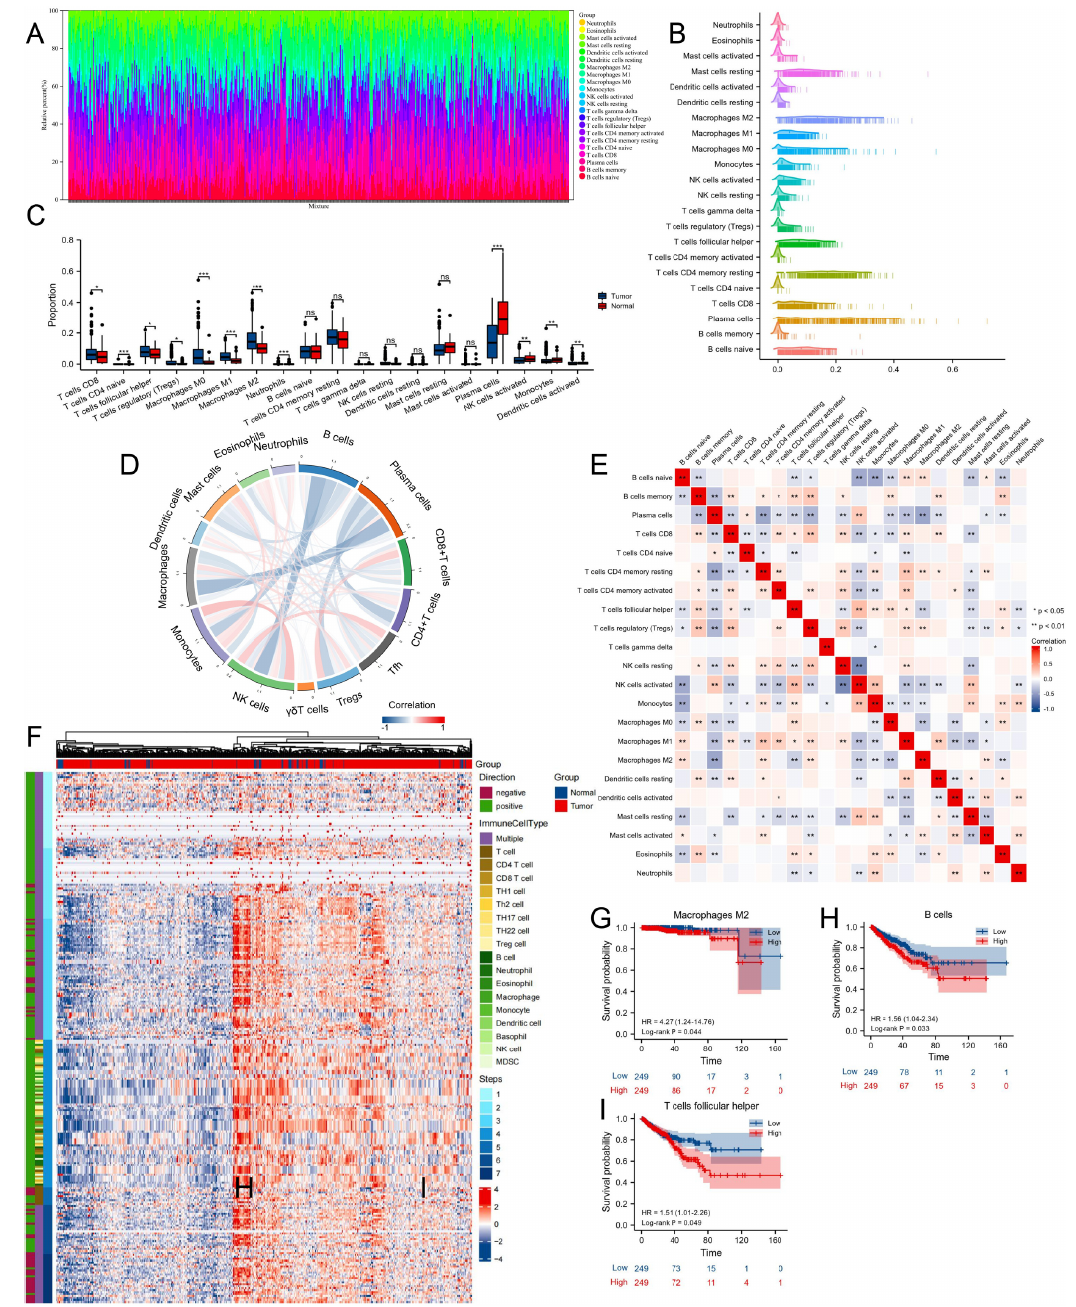
Figure 8. Evaluation of the proportions of immune cell infiltration by CIBERSORTx in TCGA-PRAD cohorts. ( A ) Bar plot and ( B ) ridge plot show the proportion of 22 types of immune cell infiltration. ( C ) Boxplots show the differences in the immune cell distribution between tumor and normal tissues. ( D ) Chord diagram and ( E ) heatmap show the correlation patterns of infiltrating immune cells. ( F ) Heatmap shows the status of anti-cancer immunity across 7-step Cancer-Immunity Cycle. ( G ) The survival curves of macrophages M2 high- and low-infiltration groups in OS. The sur- vival curves of ( H ) B cell and ( I ) Tfh high- and low-infiltration groups in PFS. No significance, p -values < 0.05, 0.01, and 0.001 were presented as “ns”, “*”, “**”, and “***”,